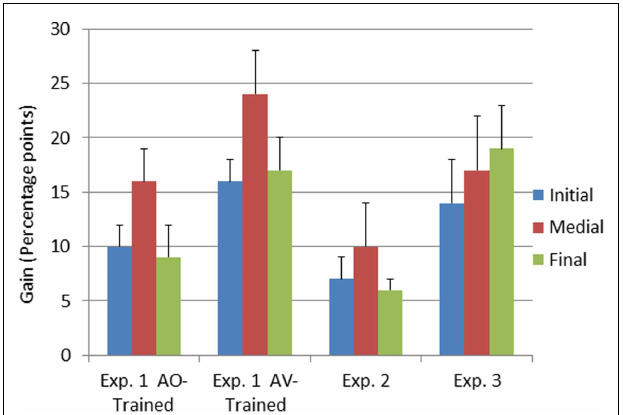
FIGURE 4 | Pre-to-post-training gain scores as a function of experiment and consonant position. Gain scores represent the means of the arithmetic difference between first and second forced-choice consonant identification test scores obtained in Experiments 1–3.The error bars represent 1 SE of the mean. Results are shown separately for the three consonant positions in the CVCVC